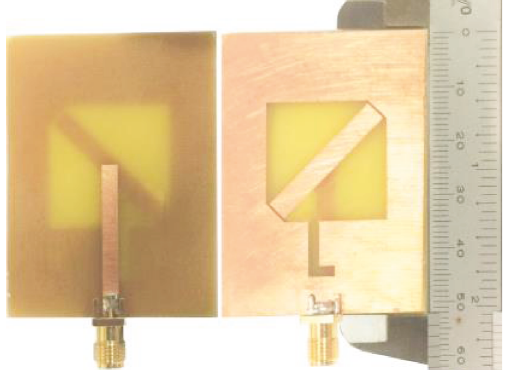
Figure 14: The front and rear view of the prototype of the proposed dual-frequency WLAN-enabled antenna.